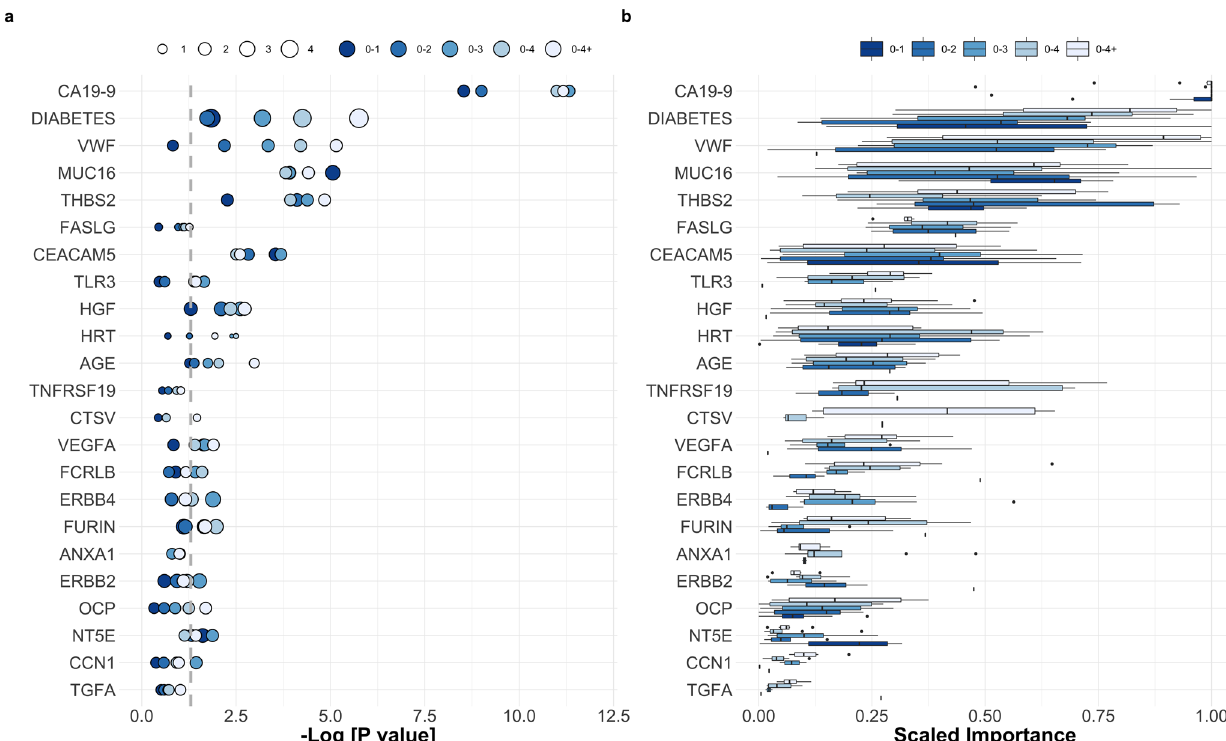
Fig. 2 Feature importance across pancreatic ductal adenocarcinoma base-learner signatures. a Odds-ratios (represented proportionally by the size of the circles) and P -values for the ranking procedure according to a logistic regression model using Firth ’ s bias reduction method in the training set. b Feature importance across all base learners and joined time-groups. All the features (biomarkers and clinical covariates) presented in this fi gure were selected when training/optimizing the ensemble approach with 0-4 + samples. The importance plotted for the remaining joined time-groups is the importance of each feature in their respective models. See also Supplementary Fig. 33 for the full plots and additionally Supplementary Fig. 34 for models developed with single time-groups. In a and b shades of blue from dark to light correspond to results obtained in 0-1, 0-2, 0-3, 0-4 and 0-4 + years to diagnosis samples, respectively. See ‘ Statistical analysis ’ in Methods for further details and Supplementary Data 4, 5. OCP oral contraceptive pill use. HRT hormone replacement